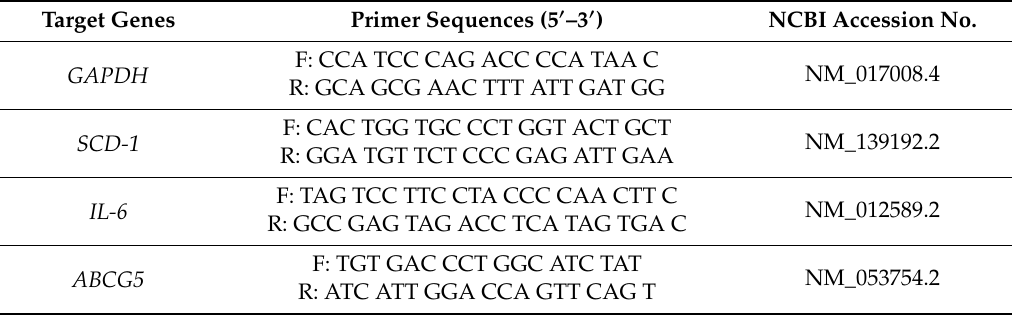
Table 2. List of primer sequences used for quantitative real-time polymerase chain